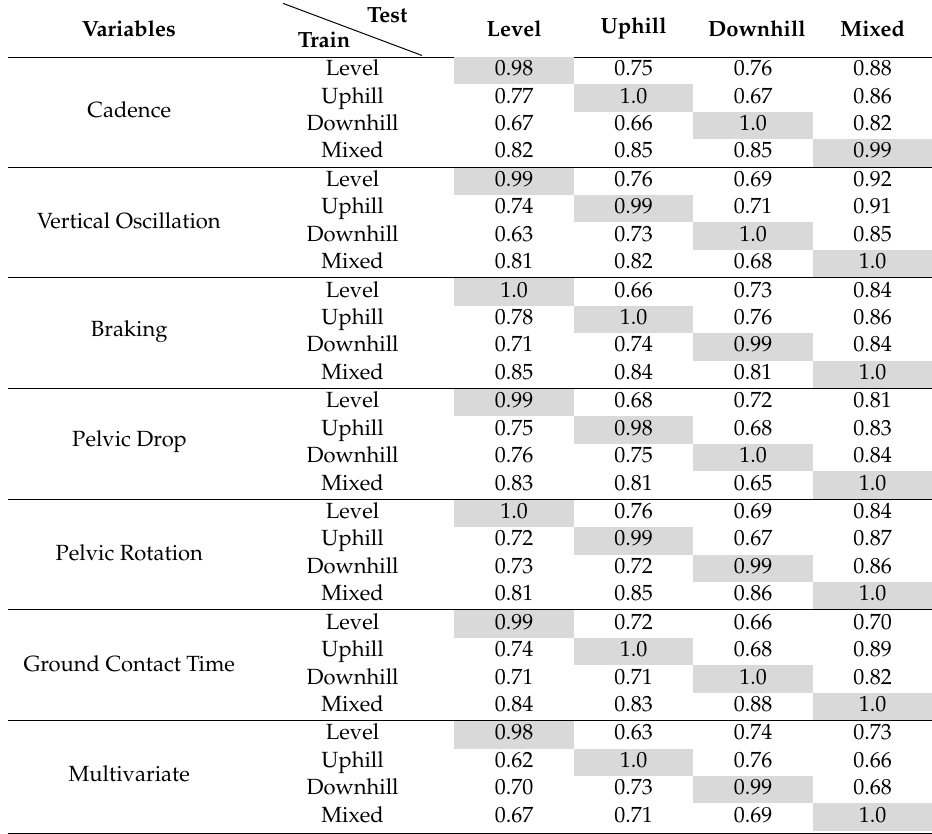
Table 4. Correlation matrices of similar data points between training and testing data sets. Grey cells indicate resultant r-values when training and testing data sets were from the same running conditions Test Variables Level Train